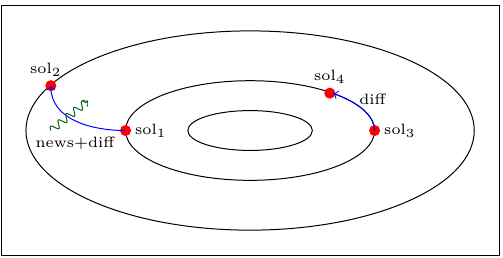
Figure 4 . Solution space, schematically. Each point represents a solution, labeled by surface charges. On the right, a non-trivial diffeomorphism moves along some (coadjoint) orbit of the symmetry algebra from solution sol 3 to solution sol 4 . On the left, additionally genuine or fake fluxes are switched on, moving from one orbit (sol 1 ) to another (sol 2